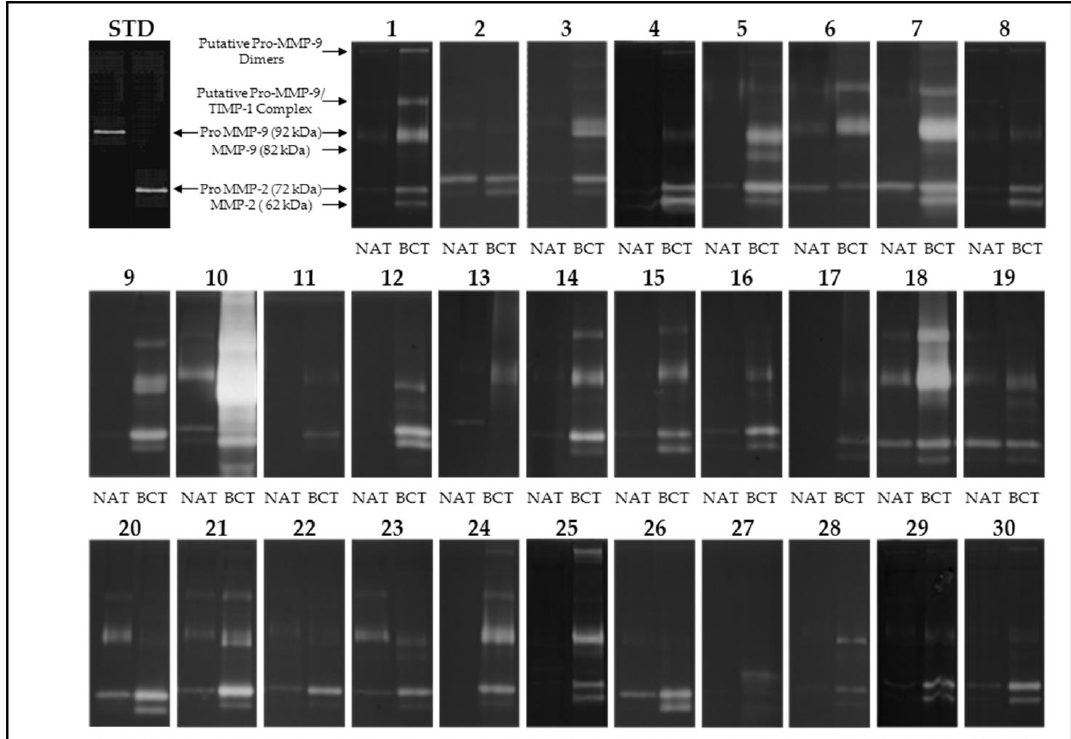
Figure 1. Gelatin zymography of 30 selected breast cancer tissues (BCT) and their non-tumoral adjacent tissues (NAT). Samples were run in parallel with purified MMP-2 and MMP-9 as a standard (lanes STD). The higher molecular weight (MW) of the lytic bands were previously identified as MMP-9 dimers and MMP-9/TIMP-1 complexes [14].